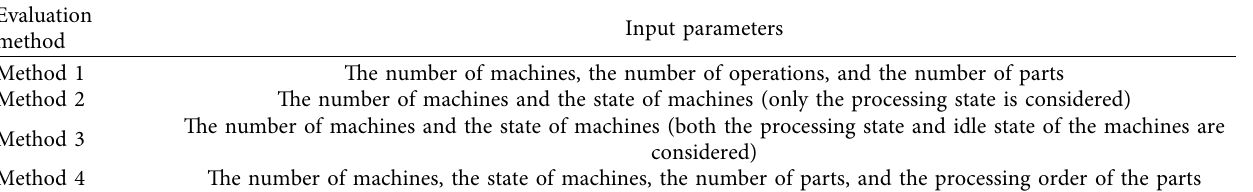
Table 1: Summary of methods for evaluating manufacturing process chain complexity.